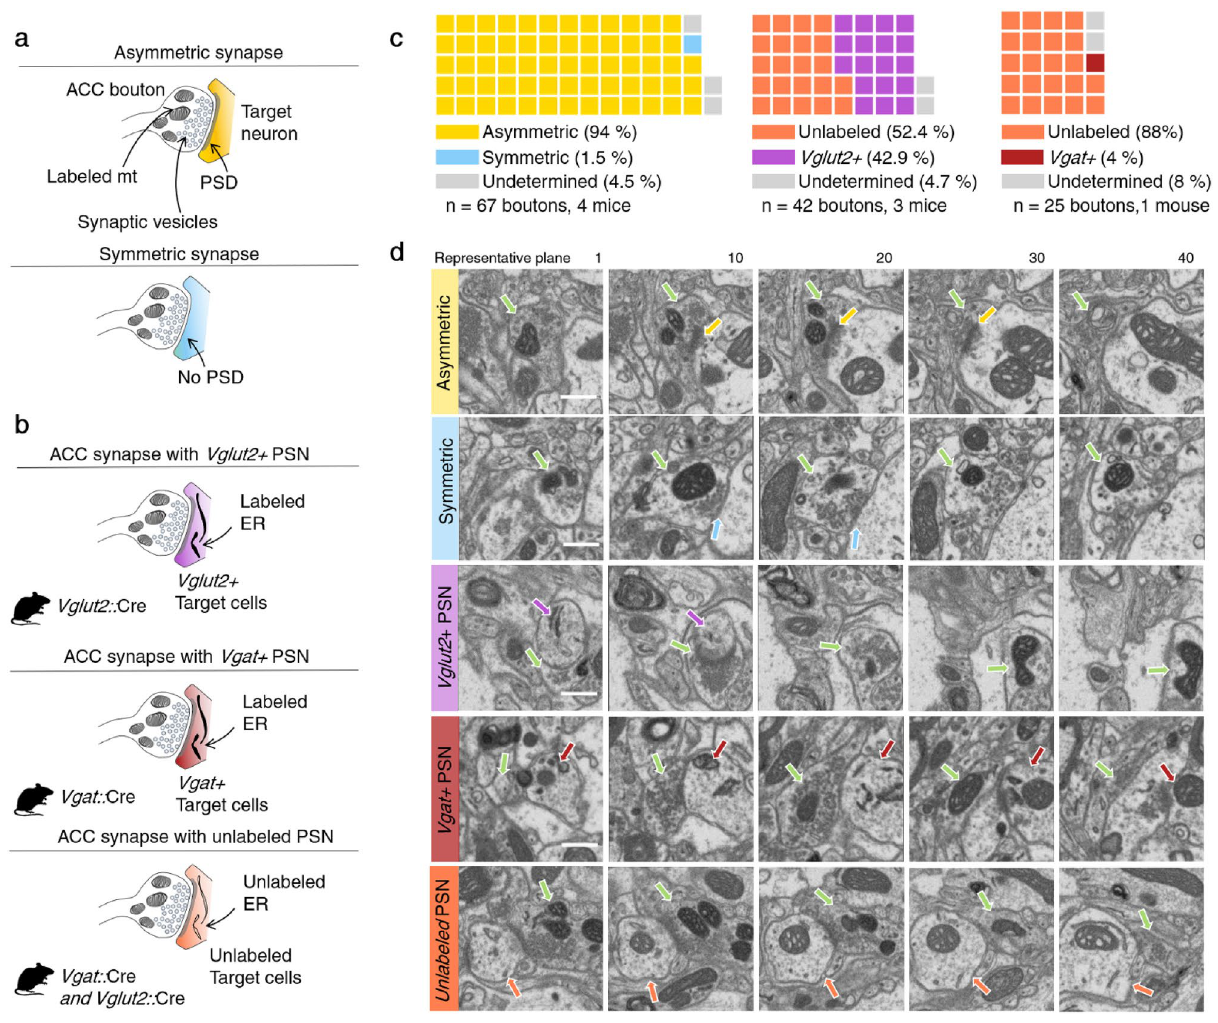
Figure 3. Identification of ACC targets in PAG. ( a ) Diagram indicating the features of asymmetric (with PSD; putative glutamatergic) and symmetric (without PSD; putative GABAergic) synapses. ( b ) Diagram indicating the three categories of ACC-dPAG synapses found. ( c ) Left: Across all mice 94% (63/67) of ACC boutons established asymmetric and 1.5% (1/67) symmetric synapses. Middle: in Vglut2 ::Cre mice 42.9% (18/42) of ACC boutons established synapses with Vglut2 + cells, while 52.4% (22/42) of them established synapses with unlabeled cells. Right: 4% (1/25) of ACC boutons established synapses with Vgat + cells, while 88% (22/25) established synapses with unlabeled cells. ( d ) Exemplary consecutive planes of an asymmetric synapse, a symmetric synapse, and contacts with a Vglut2 + , Vgat + , and unlabeled postsynaptic neuron (PSN; scale bar is 1 µm; green arrow: presynaptic cell with labeled mitochondrion; purple arrow: postsynaptic cell with labeled ER in Vglut2 + cell; red arrow: postsynaptic cell with labeled ER in Vgat + cell; orange arrow: postsynaptic cell with unlabeled ER; yellow arrow: PSD; blue arrow: symmetric